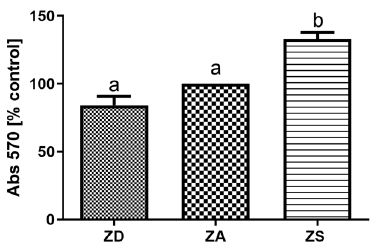
Figure 6. SF cells were cultured in CHELEX-treated medium, zinc adequate (ZA) medium or medium supplemented with zinc (50 µM) for 7 days. Afterwards the MTT test was performed. Mean values + S.E.M. of 8 replicates per treatment and n = 3 independent experiments are shown. Significantly different data sets as determined by one-way Anova and Tukey’s post hoc test do not share the same letters ( p < 0.05).